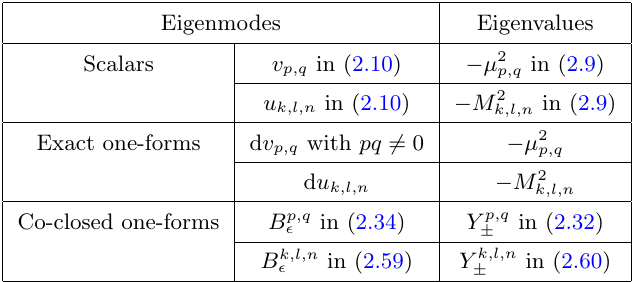
Table 1 . Scalar and one-form eigenmodes with respective eigenvalues for the Laplacian on the three-dimensional Heisenberg